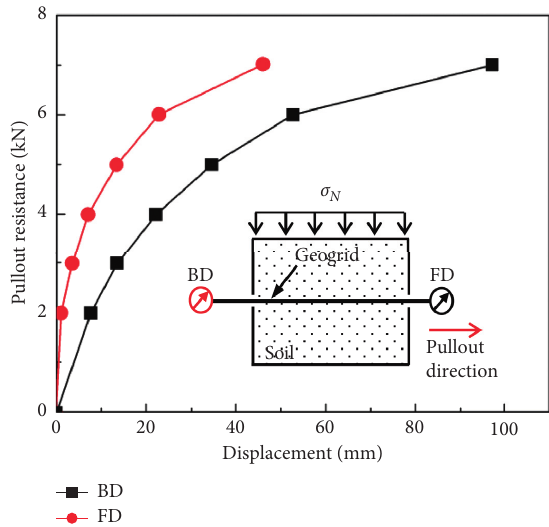
Figure 6: Comparison of FD and BD under σ � 80